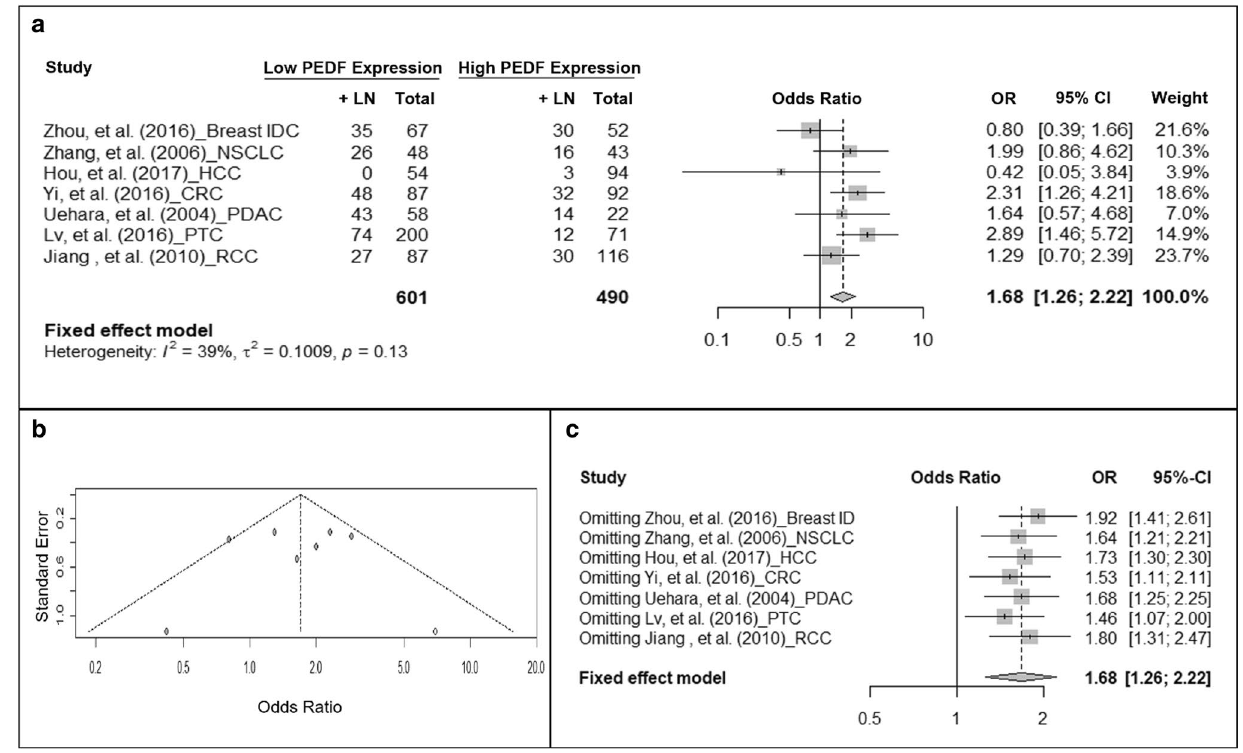
Fig. 4 Cancer with low PEDF protein expression has higher odds to invade lymph nodes. a Forest plot showing the association of PEDF expression and lymph node invasion. Squares indicate study-specific odds ratios (ORs). The size of the box is proportional to the weight of the study. Horizontal lines indicate 95% confidence interval (CI). A diamond indicates the summary OR with its corresponding 95% CI. b Fun- nel plot on the publication bias of studies on PEDF expression and lymph node invasion. Each filled circle represents one study. Open circles represent filled studies to correct publication bias. c Forest plot of sensitivity test. Squares indicate the summary OR after omitting one spe- cific study. Horizontal lines indicate 95% CI. A diamond indicates the summary OR of all the studies with its corresponding 95% CI. +LN posi- tive lymph node, IDC intra-ductal carcinoma, NSCLC non-small cell lung cancer, HCC hepatocellular carcinoma, CRC colorectal carcinoma, PDAC pancreatic ductal adenocarcinoma, PTC papillary thyroid carcinoma, RCC renal cell